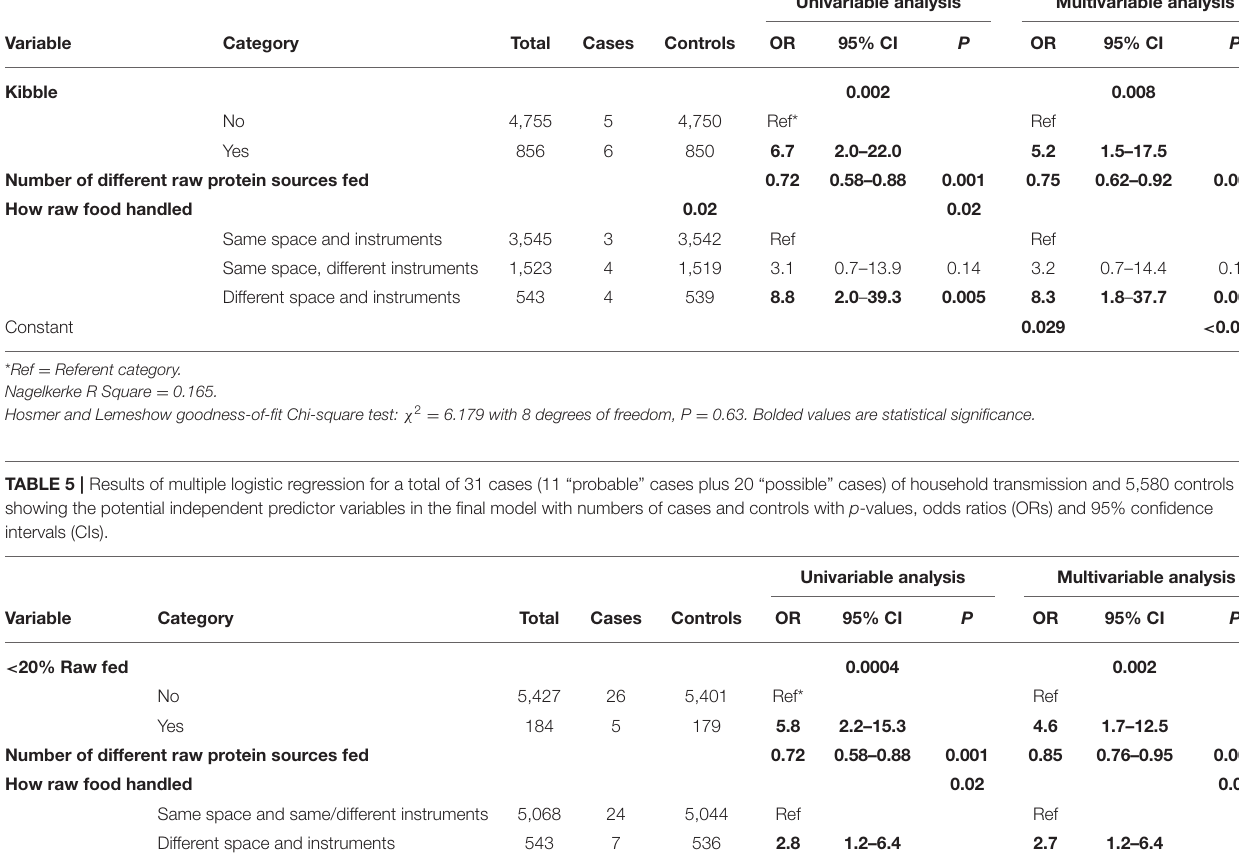
TABLE 4 | Results of multiple logistic regression for the 11 “probable” cases of household transmission and 5,600 controls showing the potential independent predictor variables in the final model with numbers of cases and controls with p -values, odds ratios (ORs) and 95% confidence intervals (CIs).